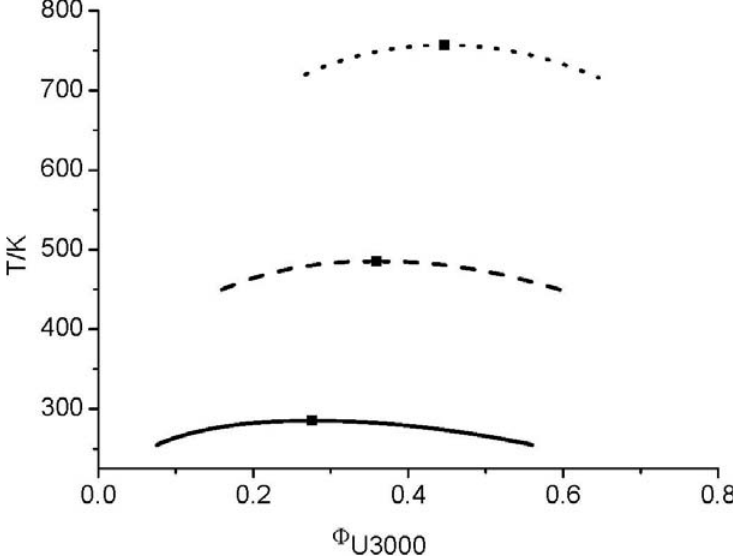
Figure 13. LCT model calculations of the mixing (symbols: critical point, lines: cloud point curves) behaviour of hyperbranched polymer Boltorn U3000 + hyperbranched polymer H20 (solid line), of Boltorn U3000 + H30 (dashed line) and Boltorn U3000 + H40 = 1 K (dotted line), where ∆ε / k B